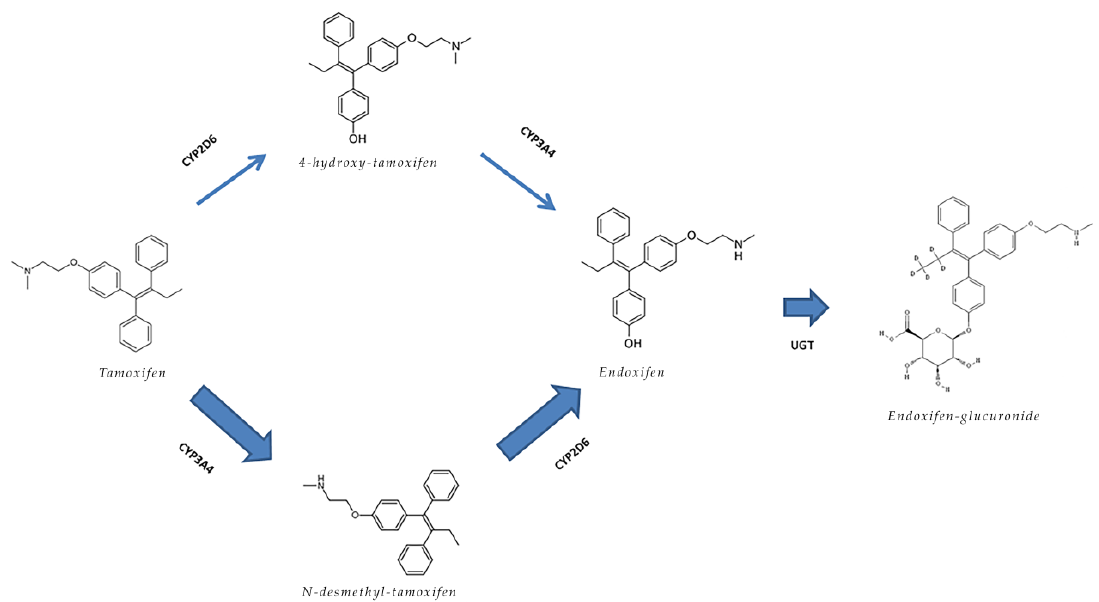
Figure 1. The major primary metabolite N -desmethyl-tamoxifen and the minor primary metabolite 4- 64 hydroxytamoxifen are formed by N -demethylation and 4-hydroxylation of tamoxifen, through 65 CYP3A4 and CYP2D6 metabolism, respectively. Further CYP-mediated metabolism of these 66 metabolites results in the formation of 4-hydroxy- N -desmetyltamoxifen (endoxifen). Endoxifen is 67 ultimately metabolized through phase II metabolism into among others endoxifen–glucoronide 68 through UDP-glucuronyltransferases (UGTs) and also through sulfotransferase (SULT) enzymes. 69